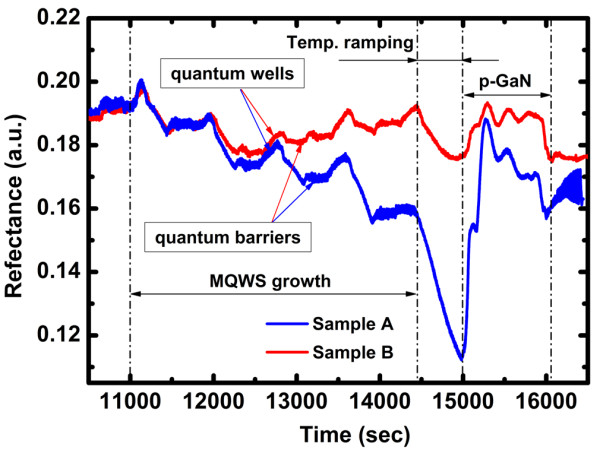
Reflectance traces of InGaN/GaN MQW green LEDs' growth monitored by 405-nmin situsystem.